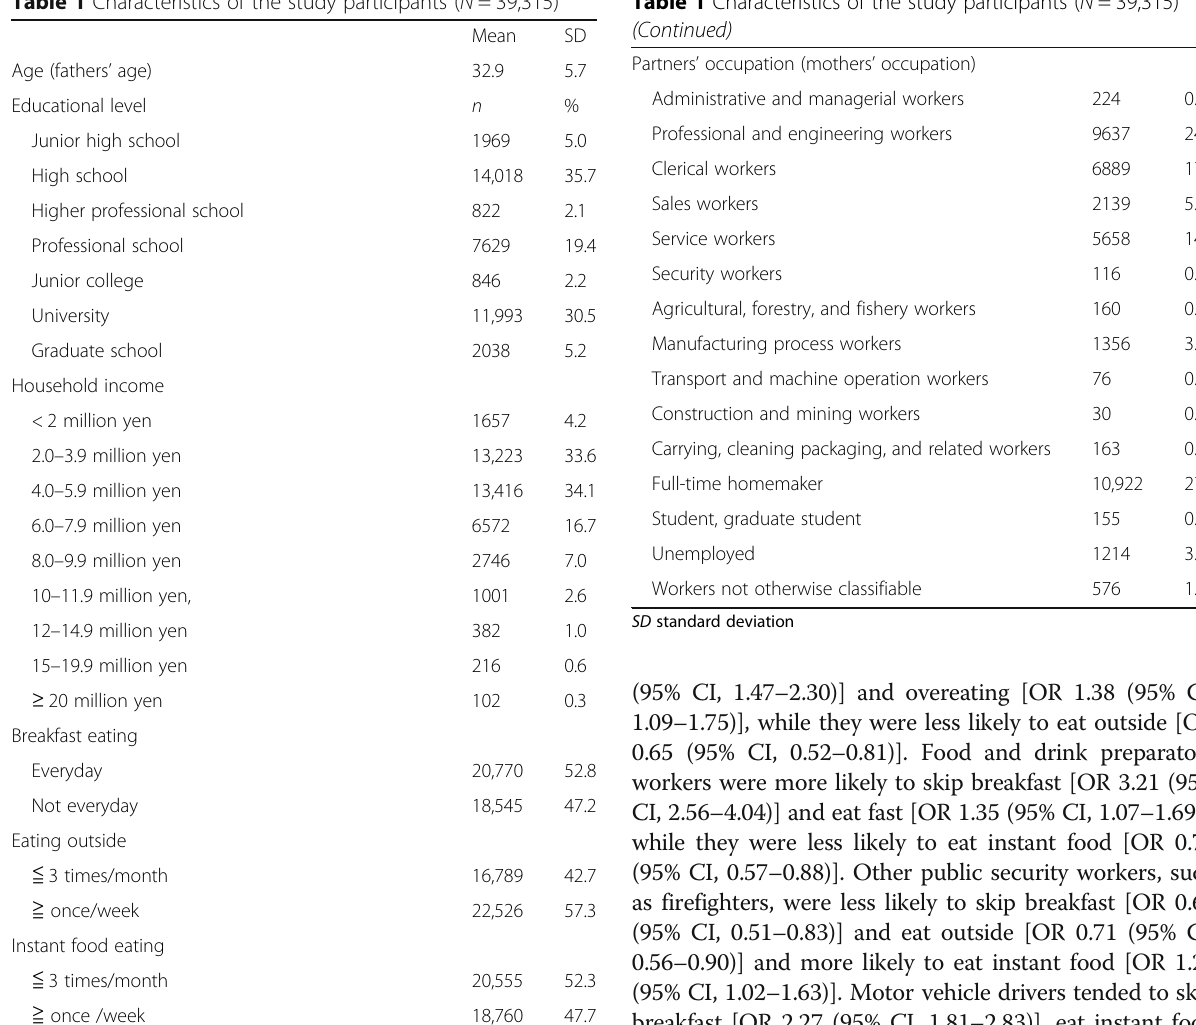
Table 1 Characteristics of the study participants ( N = 39,315)